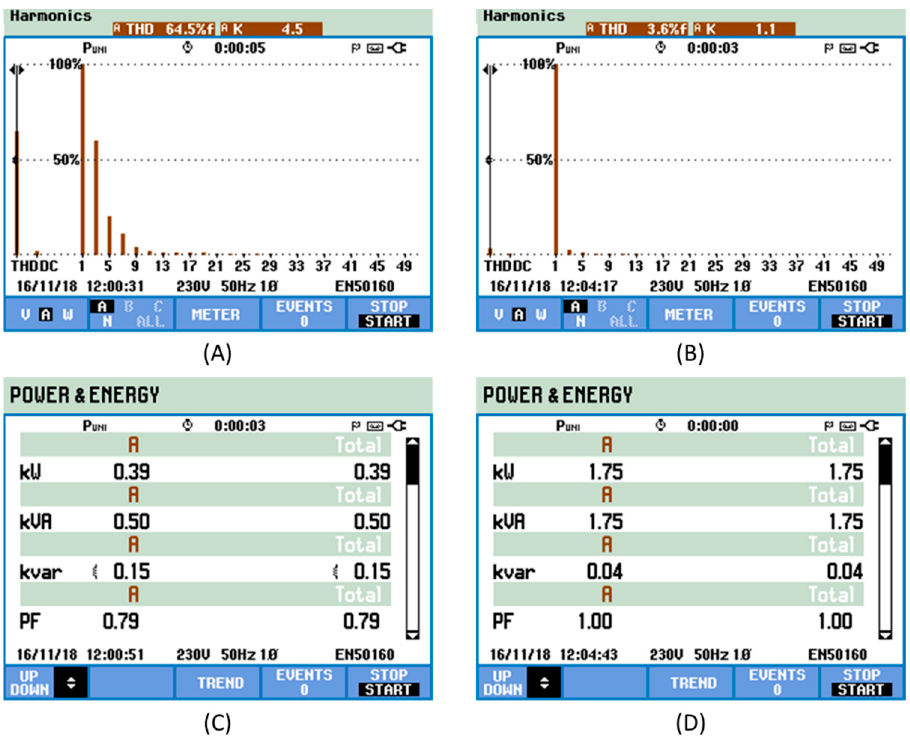
Figure 9. Experimental values for smart home #1. THD value and harmonic spectrum of the: ( A ) Current of the AC grid ( i AC# 1 ); ( B ) Total current of the hybrid AC/DC grid ( i gsh# 1 ). Consumed powers and power factors for the: ( C ) AC grid; ( D ) Hybrid AC/DC grid.